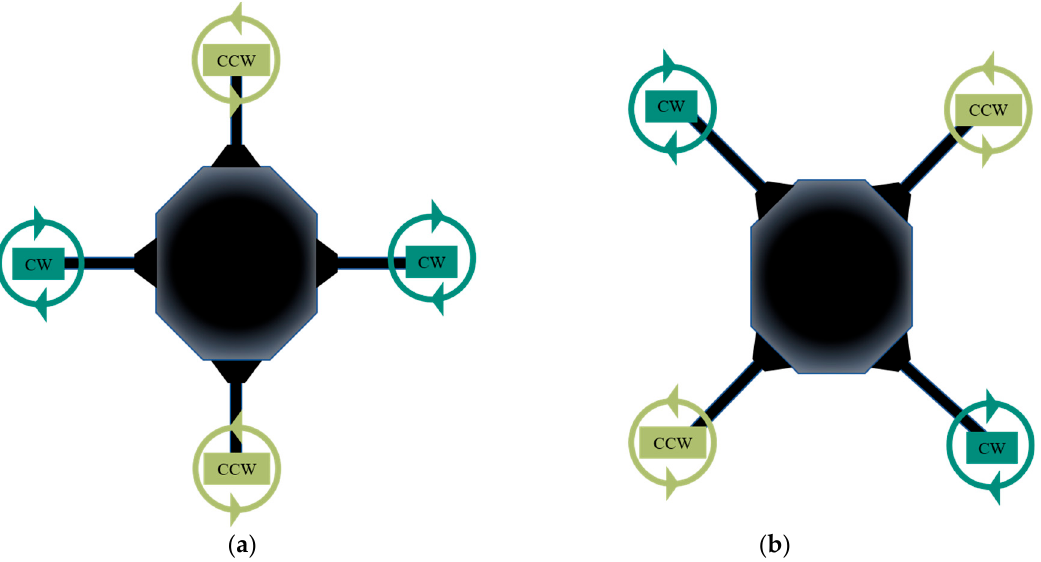
Figure 2. Structure schematic of quadrotor plant-protection UAVs (( a ) cross type; ( b ) x type).